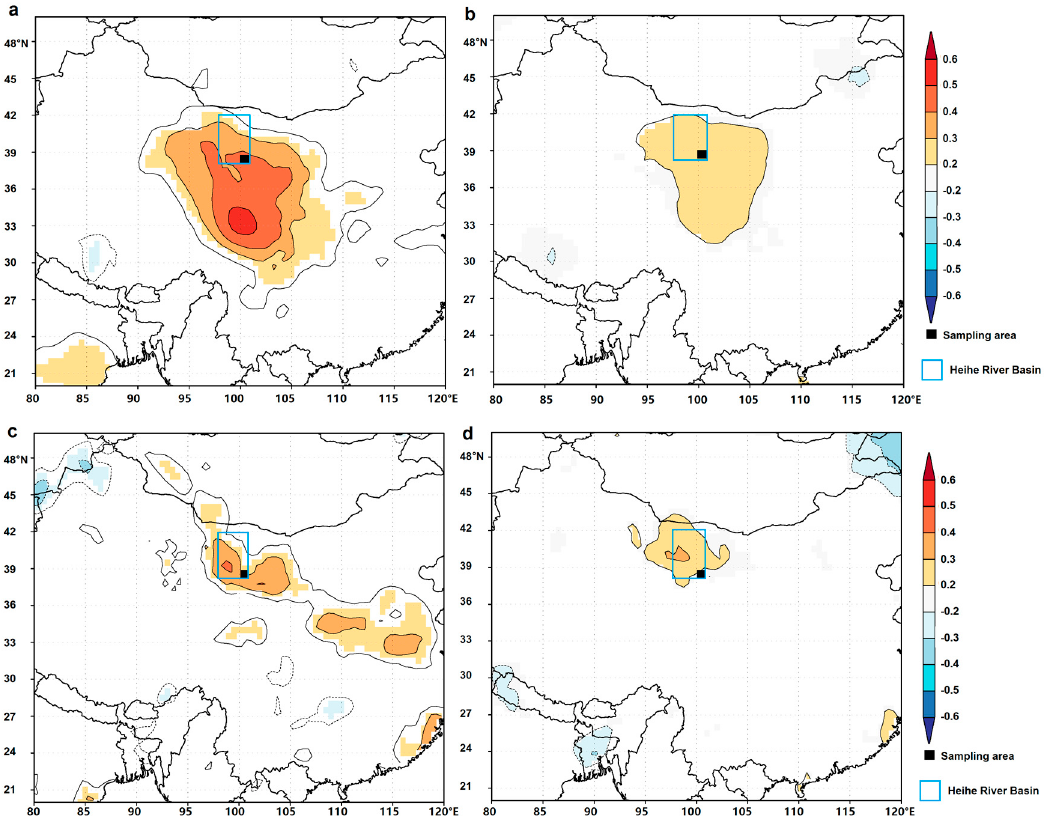
Figure 7. The spatial correlations between gridded cloud fraction data and ( a ) the observed-(1957–2012) and ( b ) reconstructed inter-annual differences in precipitation (1901–2012) in September–October; and the spatial correlations between the gridded October SPEI_01 data and ( c ) the observed-(1957–2012) and ( d ) reconstructed inter-annual differences in precipitation (1901–2012) during